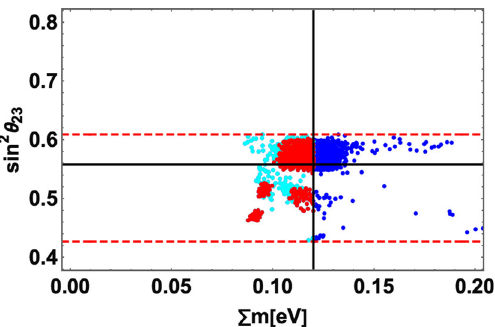
(cid:20) Fig. 5 Allowed region on m i –sin 2 θ 23 plane, where the horizontal solid line denotes observed best-fit one, red dashed-lines denote the bound of 3 σ interval, and the vertical line is the cosmological bound, for NH. Colors of points correspond to τ in Fig. 4